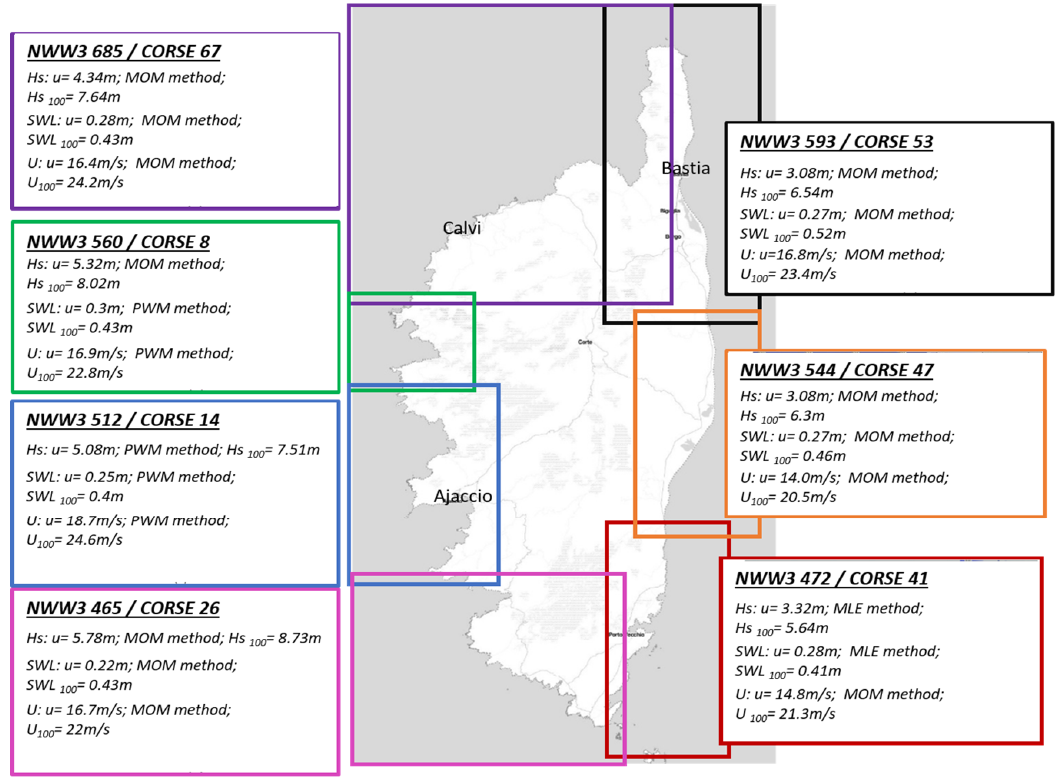
Figure A2. Observed and simulated Hs at the Cap Corse buoy, period 1999–2008.